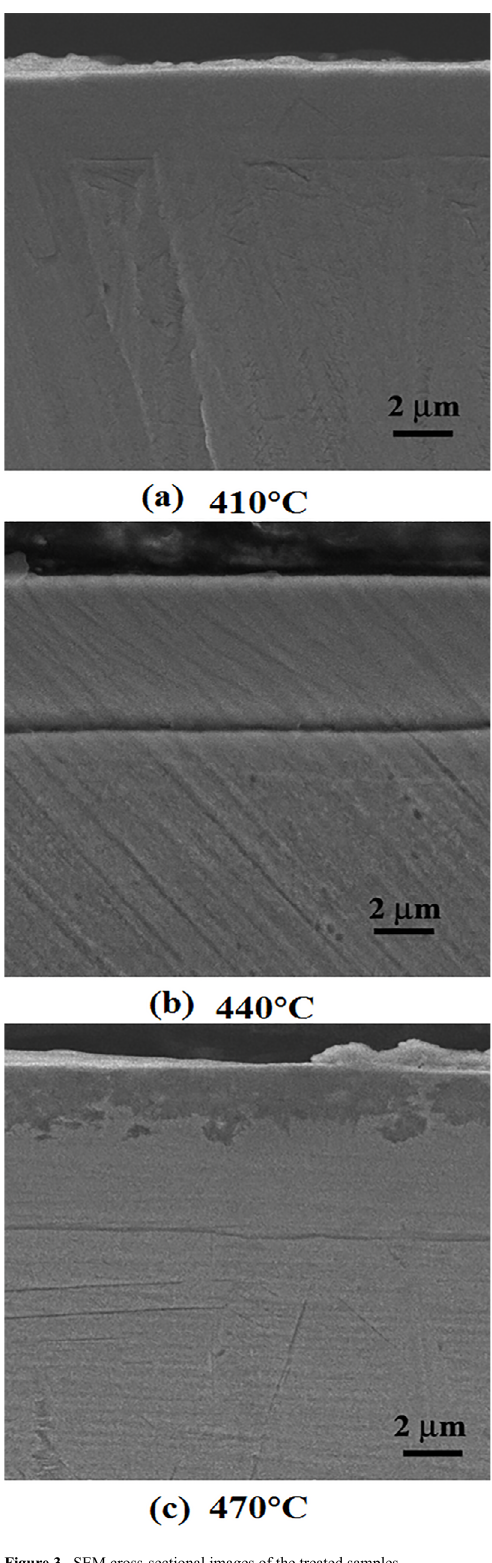
Figure 3 . SEM cross-sectional images of the treated